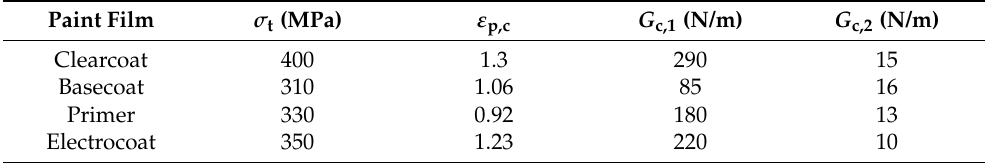
Table 2. Parameters of the damage